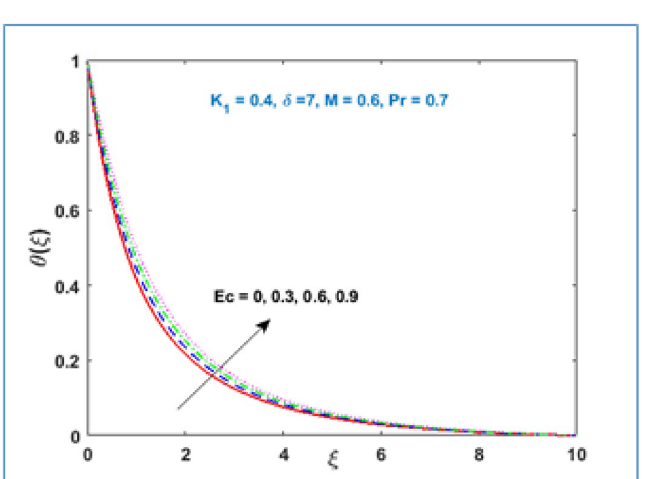
Figure 11. θ(ξ) versus Ec .